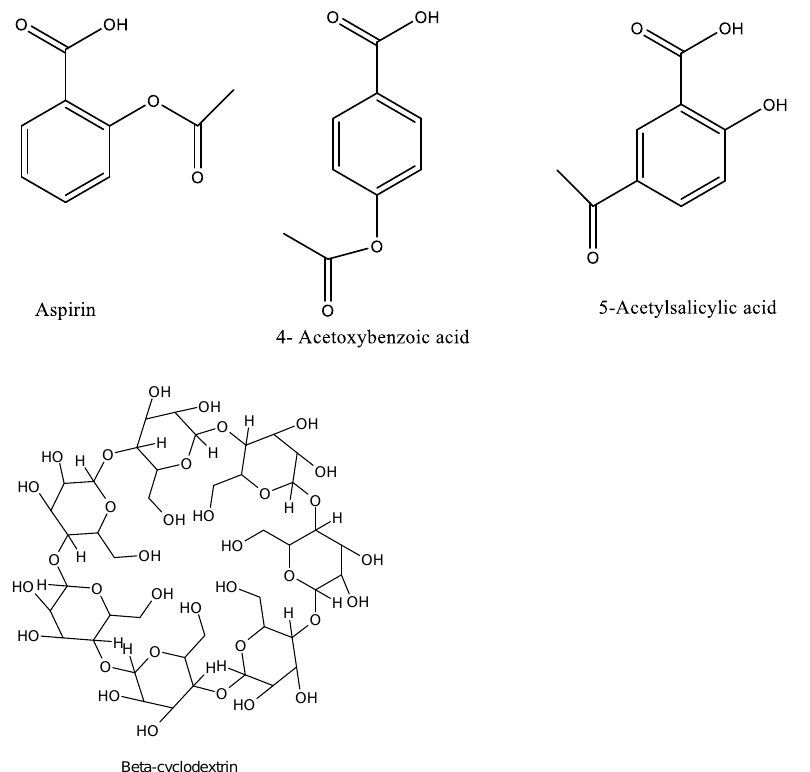
Figure 1. Chemical structures of acetylsalicylic acid (aspirin), 4-acetoxybenzoic acid, 5- acetylsalicylic acid and β -cyclodextrin. acid and β